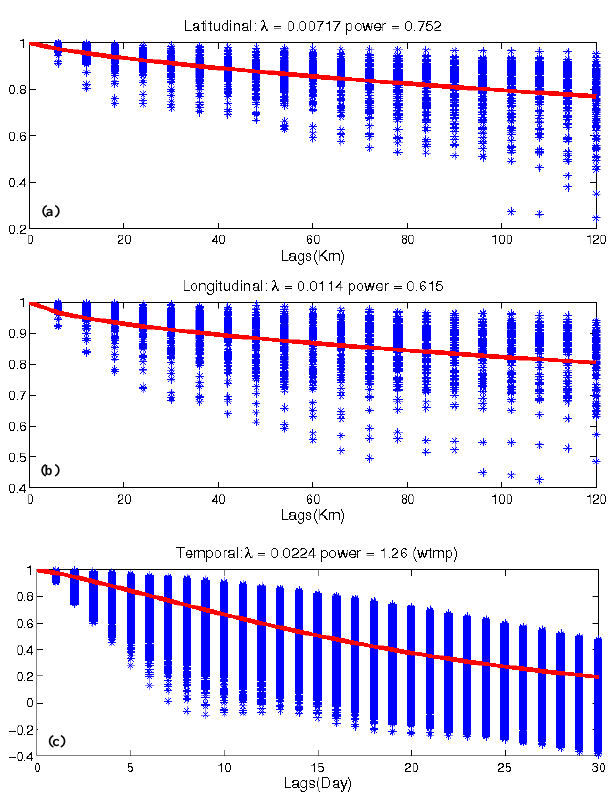
Table 1. Parameters of the mean correlation model, ρ(1x , 1y ,